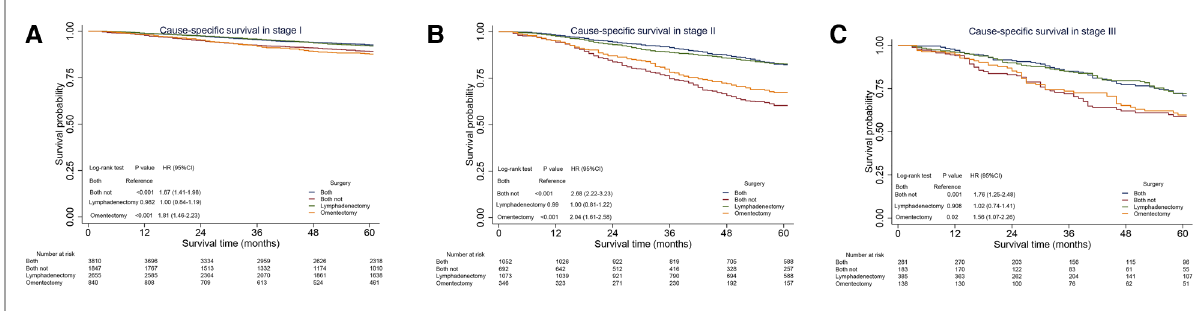
FIGURE 3 Sensitivity analysis for omentectomy and lymphadenectomy on cause-speci fi c survival (CSS) in Stage I – IIIA epithelial ovarian cancer. ( A ) CSS in Stage I EOC. ( B ) CSS in Stage II EOC. ( C ) CSS in Stage IIIA1 EOC. CI, con fi dence interval; HR, hazard ratio. P <0.05 indicates statistical signi fi